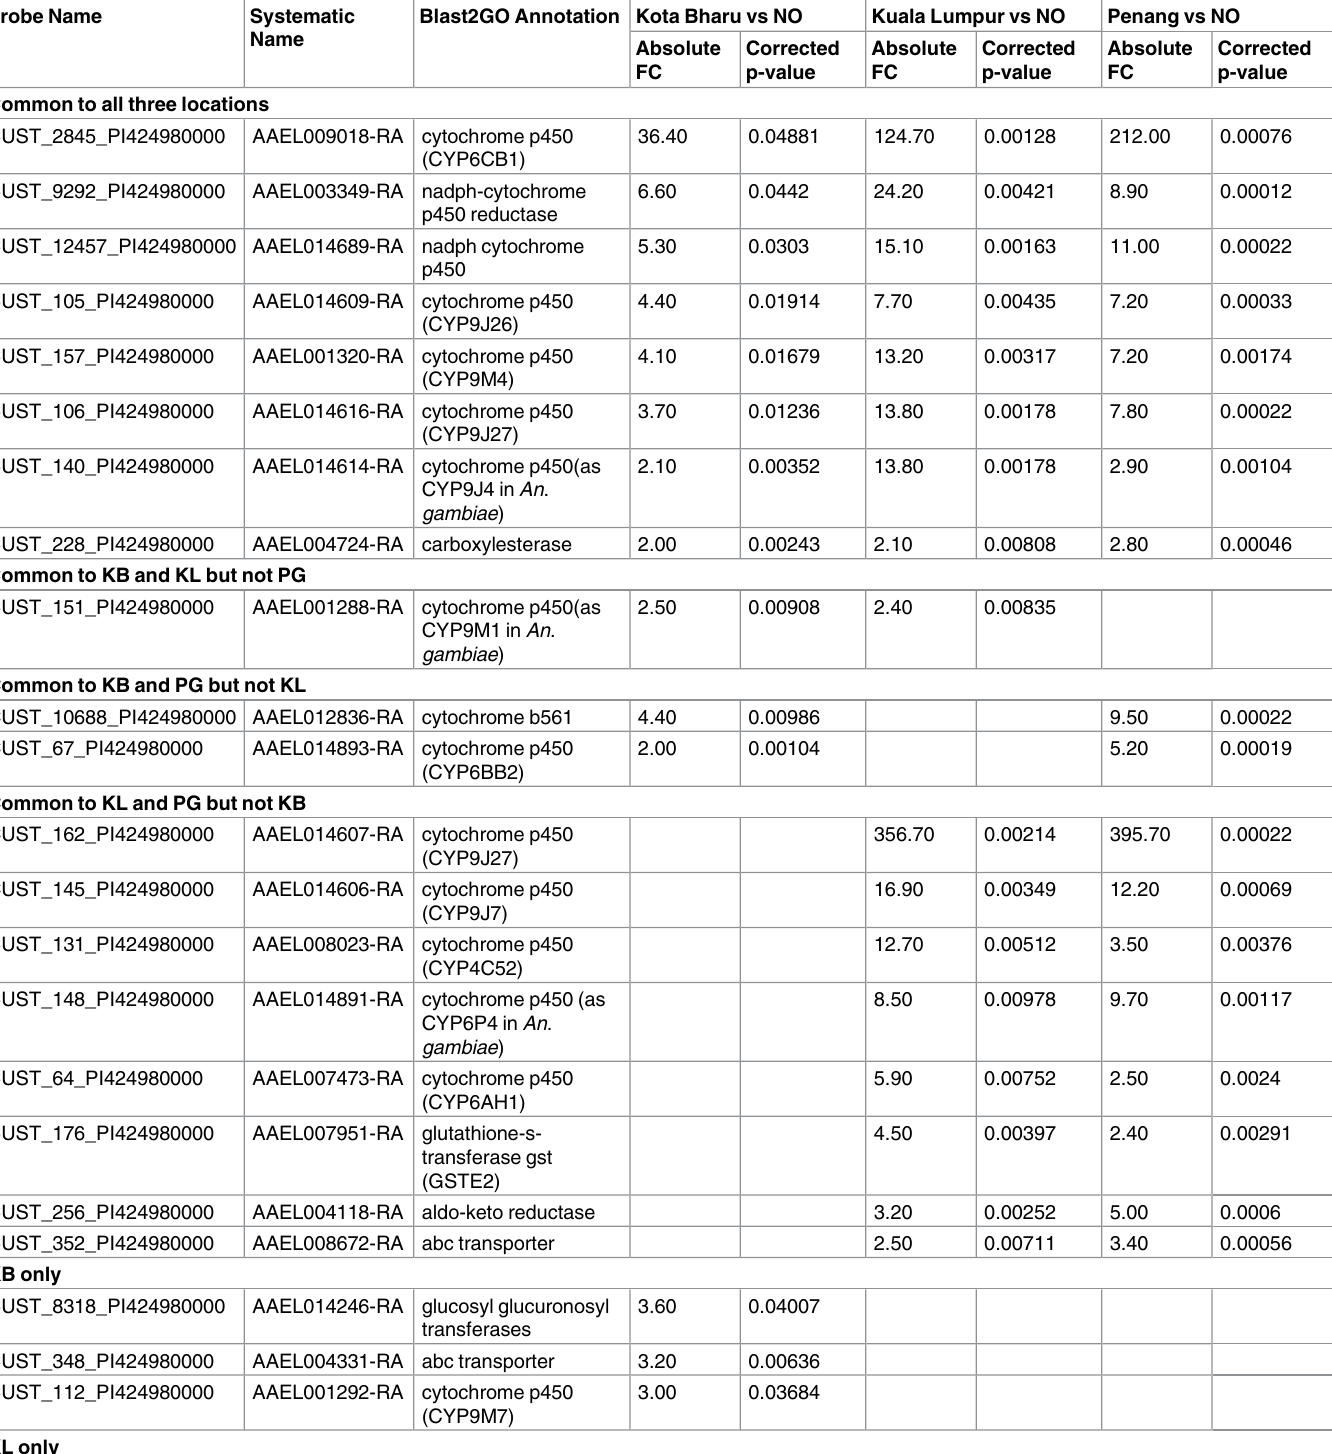
Table 1. Probes from detoxification genes & genes linked with resistance up-regulated in Malaysian populations in comparison with susceptible New Orleans strain. FC = fold change (p =